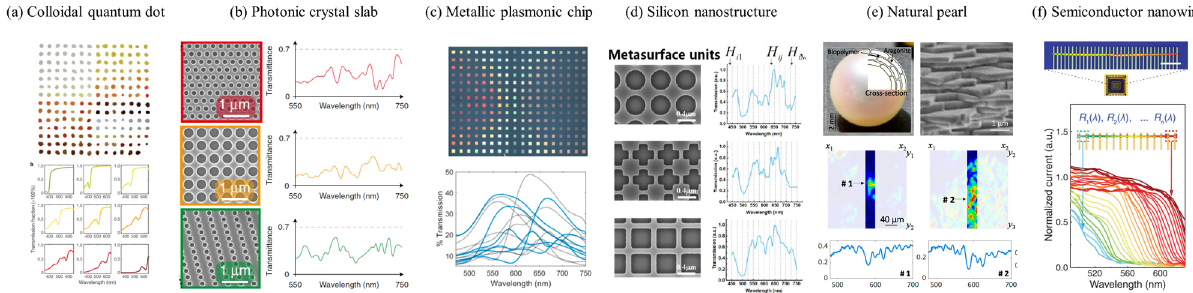
Figure2: Theresponsefunctionsgeneratedbydifferentnanophotonicstructures.(a)195colloidalquantumdotmaterialsintheformoffilters. Each dot is a CQD filter made of one type of CQD material embedded in a polyvinyl butyral thin film, with the representative transmission spectra for someof the CQD filters shown below. (b) Three scanning electron microscopy (SEM) images of selected PC-slab structures marked by red, orange, and green frames on the left and corresponding measured transmission spectra T ( λ ) of the three structures on the right. (c) Bright fi eld microscope image of the plasmonic encoder chip showing example transmission spectra T ( λ ) below. (d) Illustration of three different silicon metasurface units and their response functions, used for reconstructive spectral imaging. (e) Cross-sectional and SEM illustration of the brick-and-mortar nanostructure of pearls. Crystalline nacre is composed of aragonite platelets bound together with organic macromolecules (biopolymer). (a) Hyperspectral line-scanning along the vertical direction (middle) is acquired to measure the corresponding transmission spectra of selected spots (bottom). (f) Fluorescent micrograph (top) of a typical nanowire spectrometer incorporated into a packaged chip. Normalized spectral responses of each constituent unit in a typical spectrometer (bottom) with cutoff wavelengths